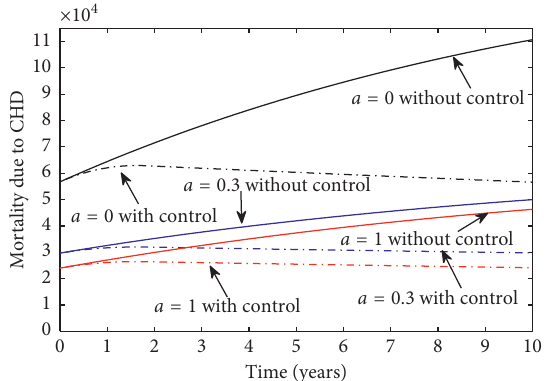
Figure 7: Mortality due to CHD with different value of a for α �